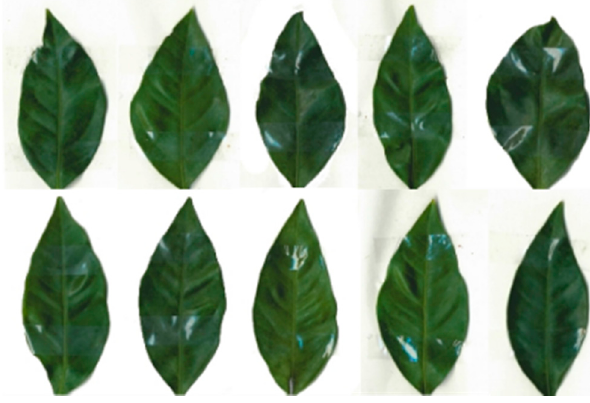
Figure 3. Sampled leaves used in this study.